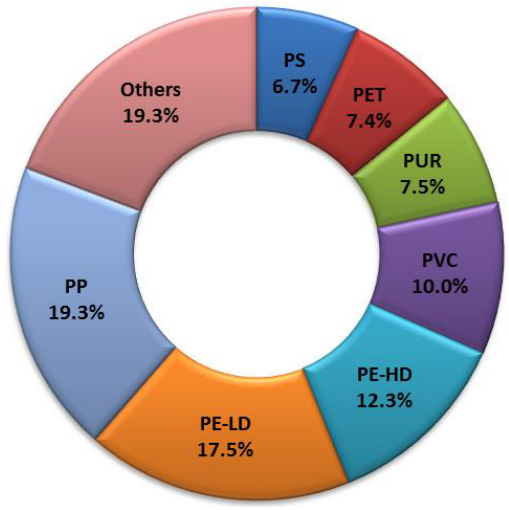
Figure 1. Plastic demand in Europe in 2016 per polymer type [2]; PP—polypropylene, PS—polystyrene, PET—polyethylene terephthalate, PUR—polyurethane, PVC—polyvinylchloride, PE-HD—high density polyethylene, PE-LD—low density polyethylene.